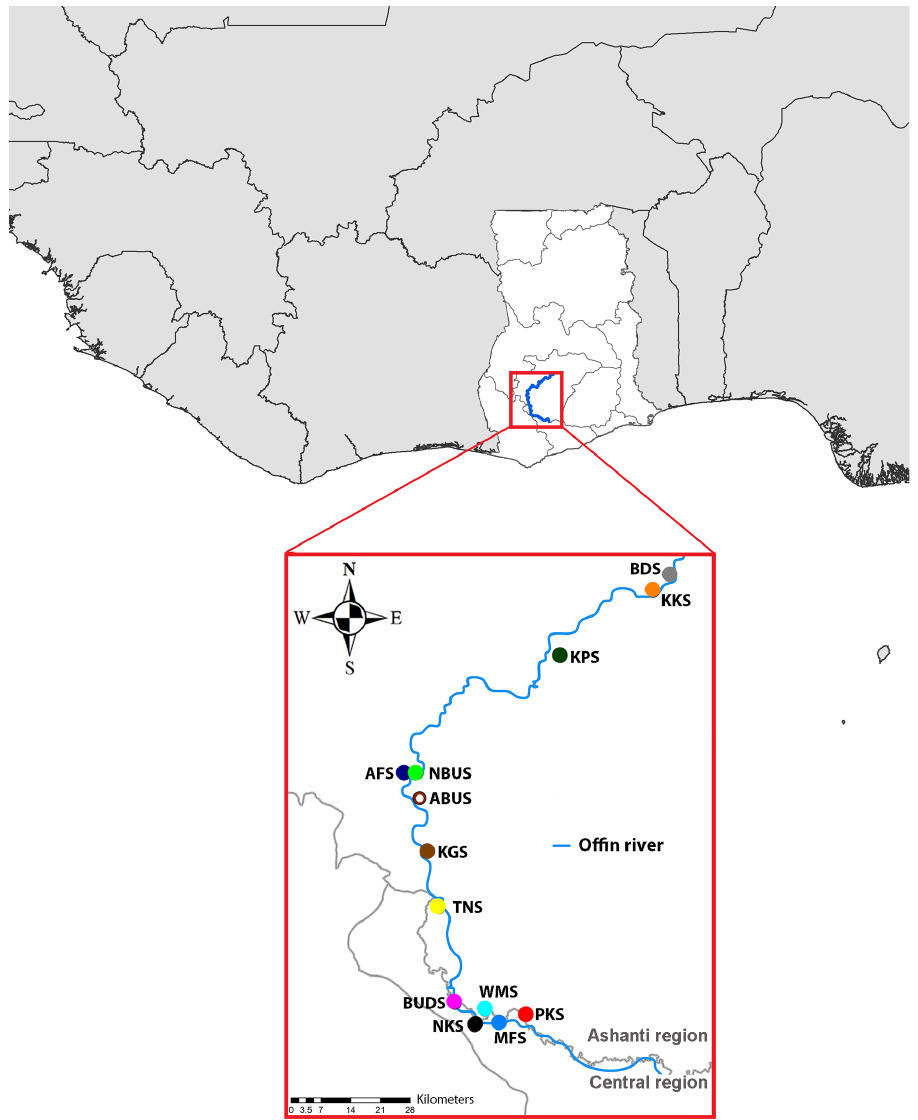
Fig 1. Study area. Map of Ghana with the Offin river valley and surrounding countries. The 13 study communities along the Offin River are indicated as multicolored dots: Bedomase (BDS); Krakrom (KKS); Kapro (KPS); Akomfore (AFS); Ntobroso (NBUS); Achiase (ABUS); Keniago (KGS); Tontonkrom (TNS); Dominase (BUDS); Wromanso (WMS); Nkotumso (NKS); Mfantseman (MFS); Pokukrom (PKS). The grey lines in the Ghana map indicate the borders of the Ghanaian regions. The background maps were created using the ArcMap program in ArcGIS v.10.0 and were modified with Adobe Photoshop CS6.